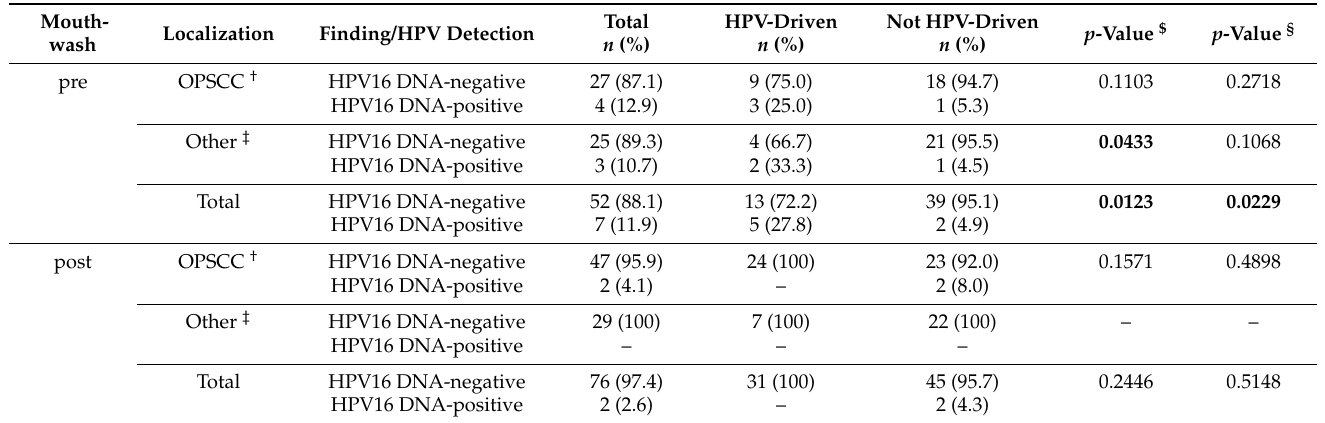
Table 3. Detection of HPV16 DNA in HPV-driven and not HPV-driven oropharyngeal squamous cell carcinoma (OPSCC) and other head and neck squamous cell carcinoma (other) in pre- and post-therapy